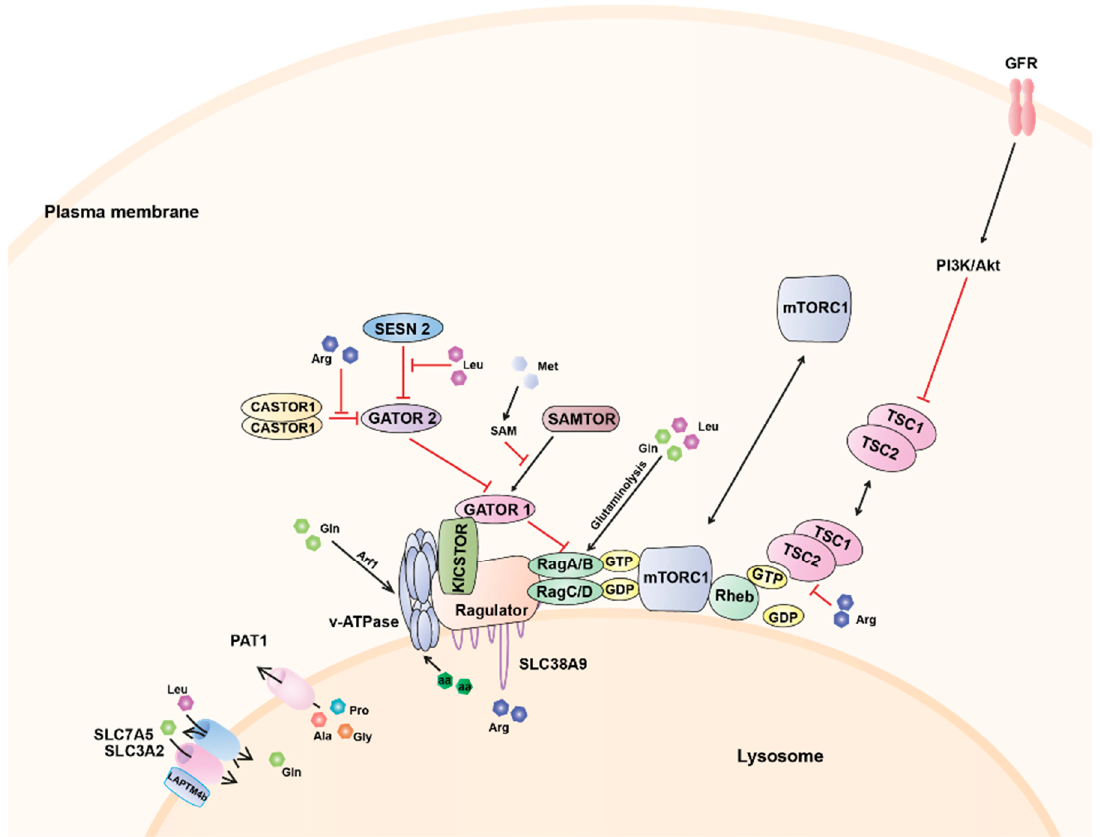
Figure 1. Components of the nutrient sensing pathway upstream of mTORC1. The activation of mTORC1 requires two conditions: the translocation of the complex to the lysosomal surface via Rag GTPases and the activation of Rheb GTPase. The presence of amino acids is essential for the activation of mTORC1 as they control the nucleotide-loading status of the Rag GTPases. Amino acids signal to mTORC1 by different mechanisms including cytoplasmic sensors (SESN2, CASTOR1, and SAMTOR), amino acid transporters (SLC38A9, PAT1, or SLC7A5/SLC3A2) and the v-ATPase on the lysosomal membrane. Growth factors (including hormones, cytokines, and chemokines) activate receptor tyrosine kinases or G-protein-coupled receptors, which, through various mechanisms, activate PI3K/Akt. When active, Akt phosphorylates and inhibits the TSC complex thereby relieving the inhibition of Rheb and allowing it to become activated and stimulate mTORC1 kinase activity. Arrows indicate stimulation and blocked arrows indicate inhibition. GFR, growth factor receptor; SESN, Sestrin; GATOR; TSC, tuberous sclerosis complex; GTP, guanosine-5 ′ -triphosphate; GDP, guanosine-5 ′ -diphosphate; PAT, proton-assisted amino acid transporter; SLC, solute carrier family; SAM, S-adenosylmethionine; CASTOR cytoplasmic arginine sensor for mTORC1; SAMTOR, S-adenosylmethionine sensor for mTORC1.